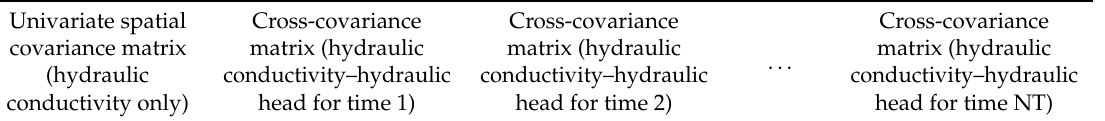
Table 4. Structure of the multivariate spatiotemporal covariance